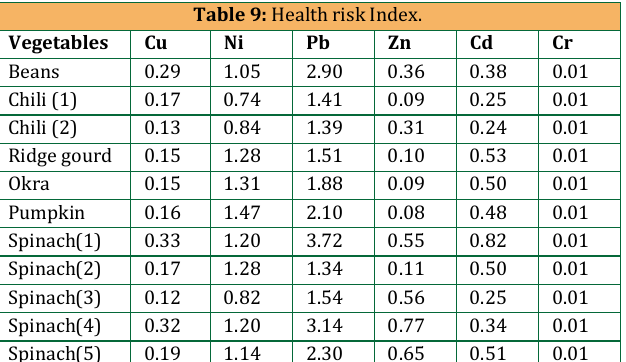
Table 9: Health risk Index.